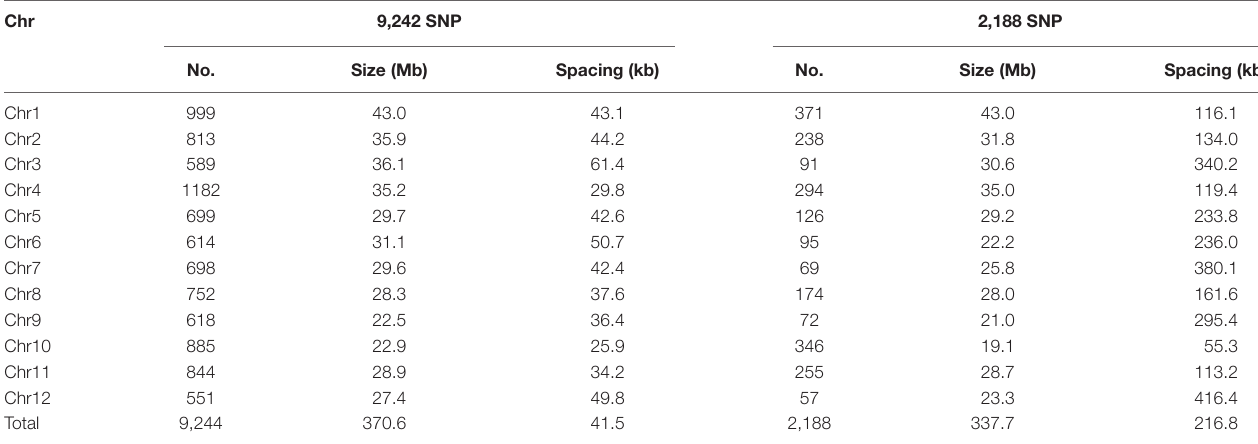
TABLE 3 | Distributions of SNP markers on chromosomes.